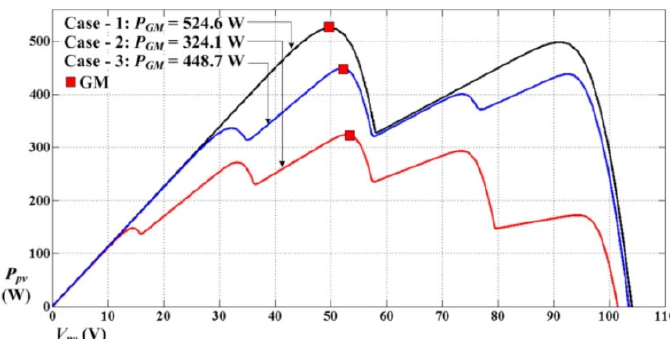
Figure 10. Magnitudes of the global maximum (GM) of three distinct shading patterns .